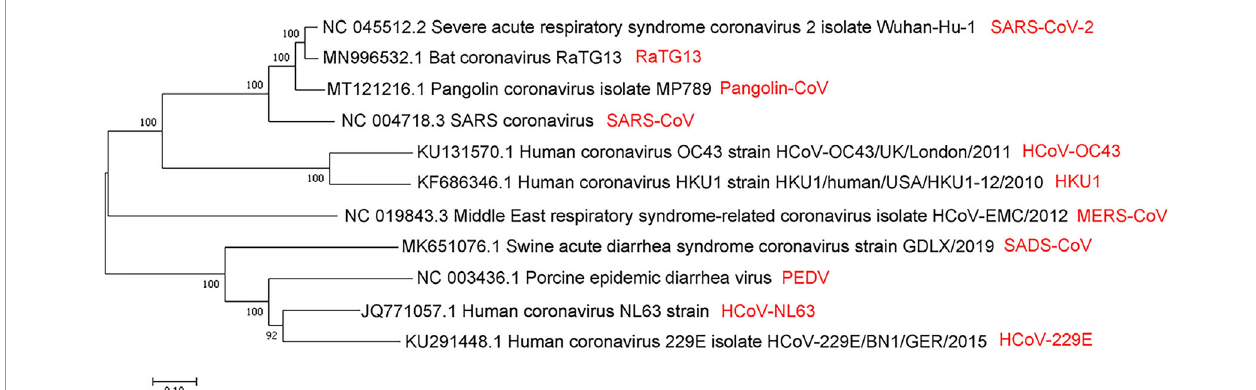
FIGURE 1 | Evolutionary relationships of SARS-CoV, MERS-CoV, SARS-CoV-2, and several viruses from a - and b -coronavirus categories by the neighbor-joining method. A coronaviruses ’ phylogenetic tree is shown based on the full-length genome sequence. All complete genome sequences of the coronavirus are downloaded from the NCBI reference sequence database RefSeq. The evolutionary relationship analysis involves 11 nucleotide sequences, including SARS-CoV, MERS-CoV, SARS-CoV-2, RaTG13, pangolin-CoV, HCoV-OC43, HKU1, SADS-CoV, PEDV, HCoV-NL63, and HCoV -229E. By using the neighbor-joining method, the evolutionary history was inferred. The optimal tree is shown, with the sum of branch length = 3.61257103. Next to the branches are shown the percentage of replicate trees (50 replicates) where the associated taxa are clustered together in the bootstrap test. The tree is drawn to scale, and its branch length is the same as the units used to infer the evolutionary distance of the phylogenetic tree. The phylogenetic tree is drawn by